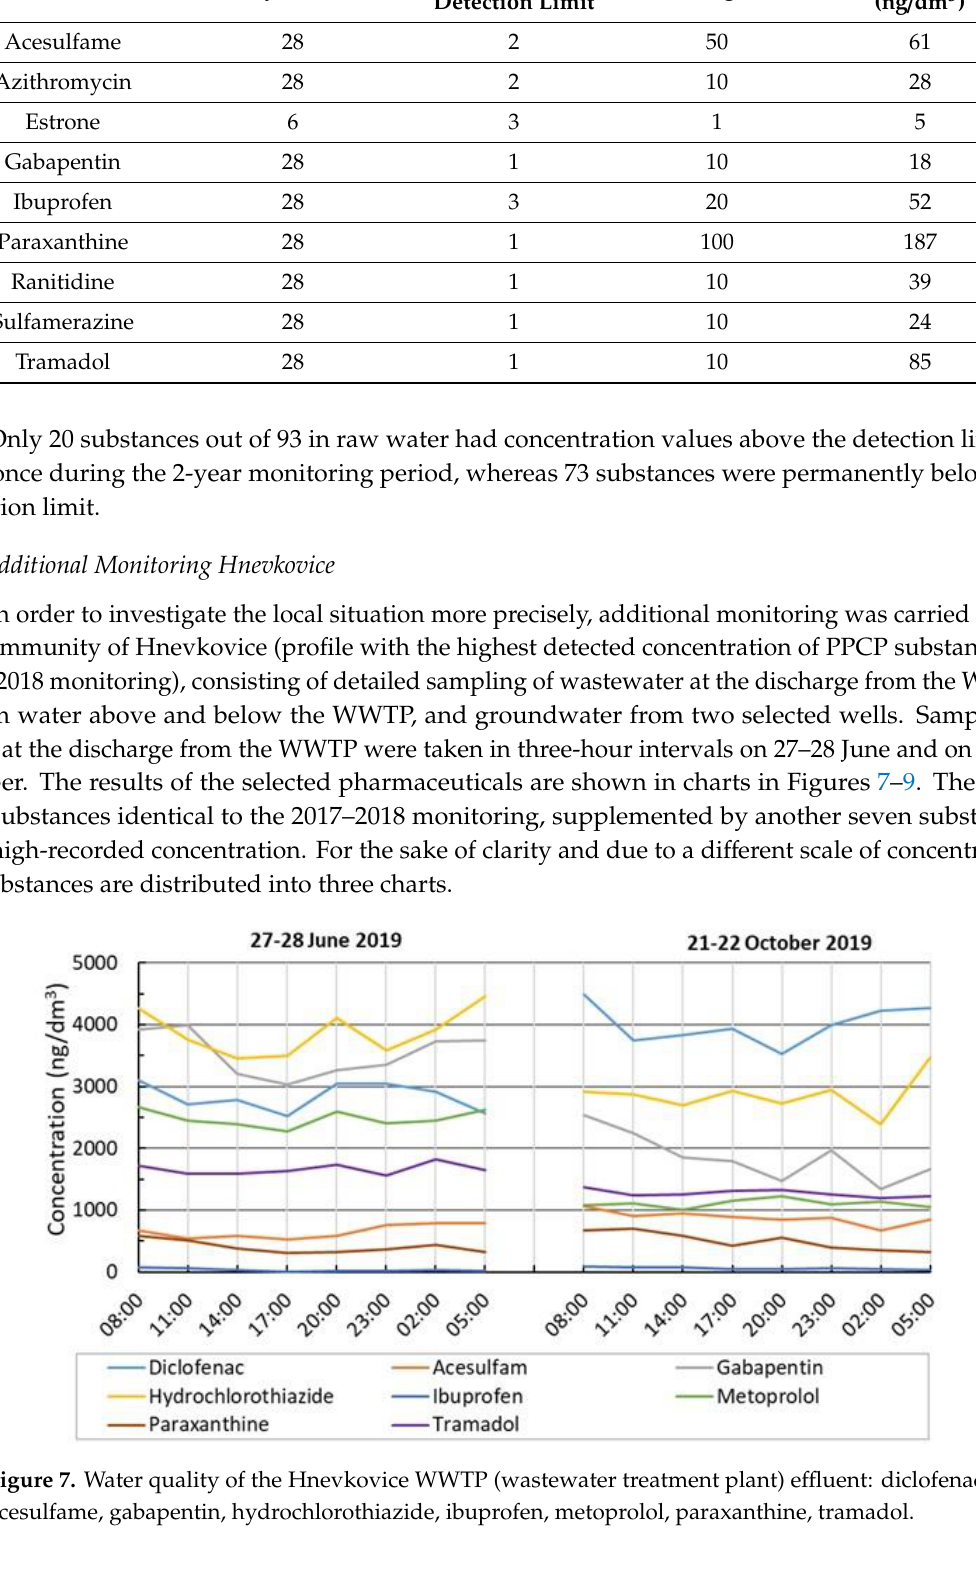
Table 12. Quality of drinking water produced — all substances detected above the detection limit.